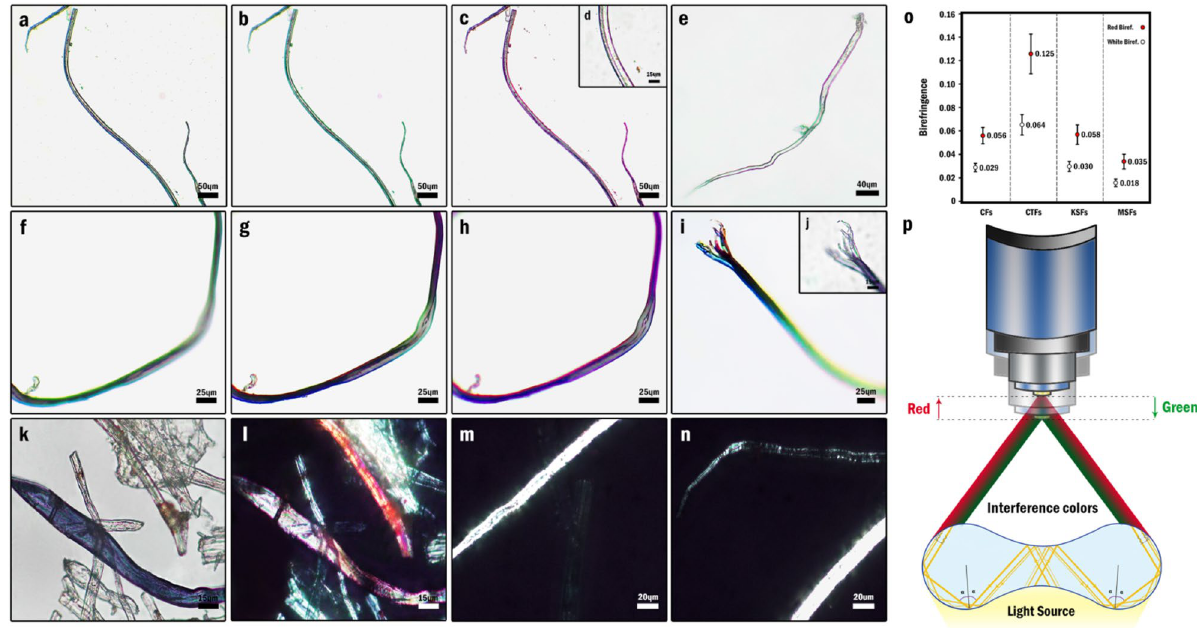
Figure 6. Marginal coloration and birefringence of dried NOG fibers, ( a ) OM image of colorless MSF in fine focus ( b ) OM image of colorless MSF with green marginal color after a trivial increase of working distance from the fine focus. ( c ) OM image of colorless MSF in fine focus with red marginal color after trivial reduction of working distance from the fine focus. ( d ) The red marginal coloration of colorless MSF in higher magnification. ( e ) Red and green marginal coloration in a colorless CTF which is not located in a single plane. ( f – h ) alteration of iridescent marginal coloration by reduction of working distance in a dark green KSF which is not located in a single plane. ( i ) Multicolored marginal coloration of MSF terminal ( j ) Absence of multicolored marginal coloration of dark green MSF terminal in higher magnification ( k – l ) OM and POM images of NOG fibers indicating strong red and white birefringence ( m – n ) POM images of KSF and MSF after 45 ◦ rotation of the